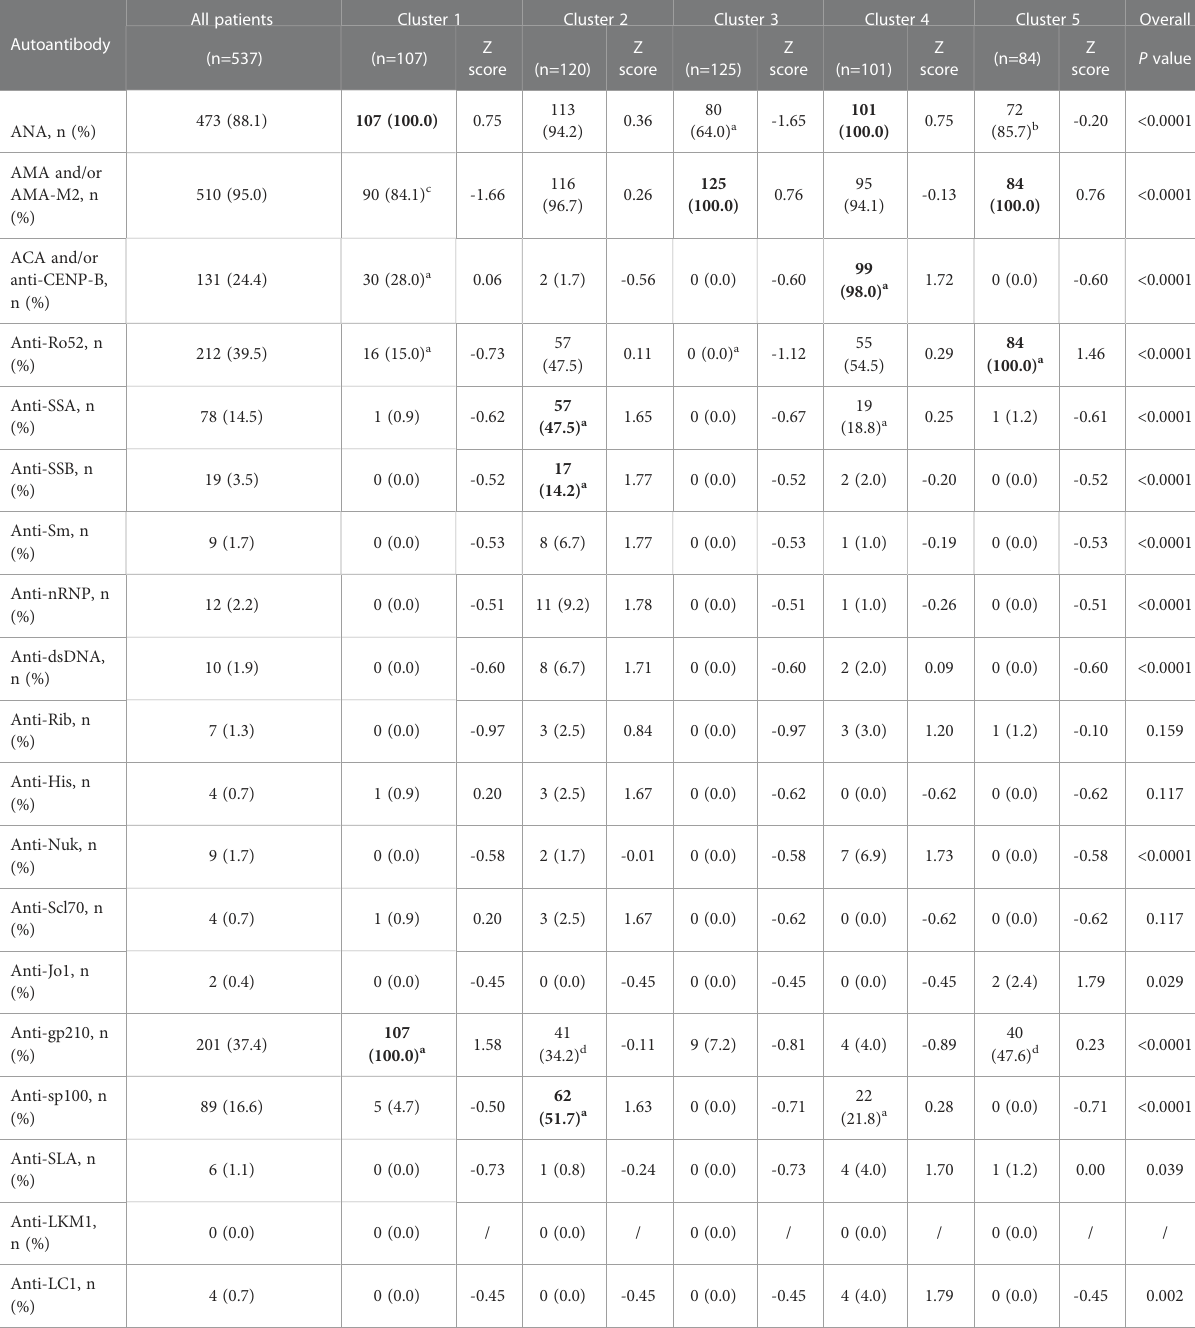
TABLE 1 Comparision and Z Score transformation of autoantibody frequencies in patients with PBC by clusters. All Autoantibody